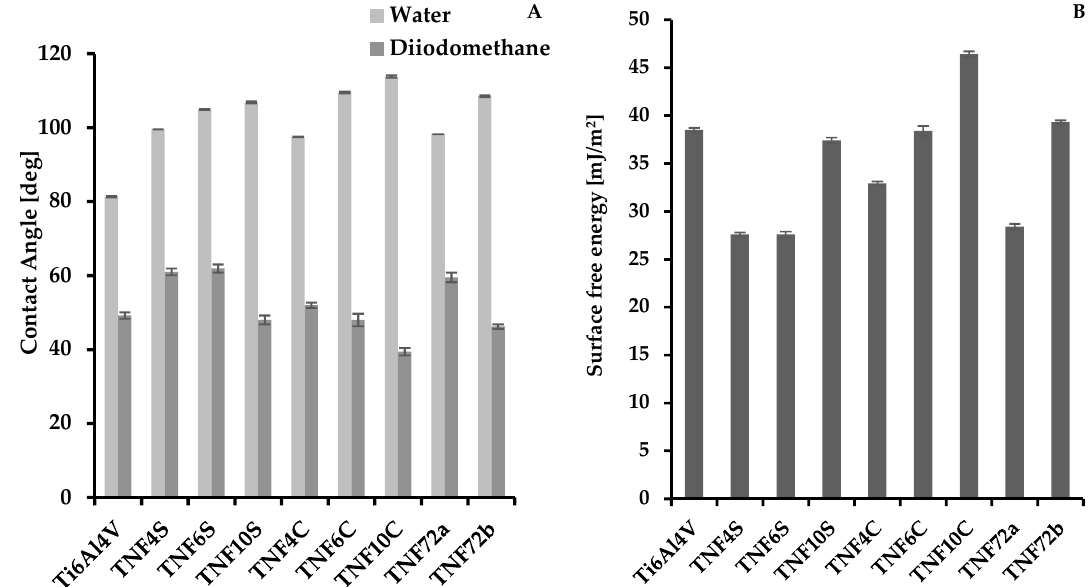
Figure 3. The values of contact angles for water and diiodomethane ( A ), and surface free energy of Ti6Al4V/TNF samples ( B ).